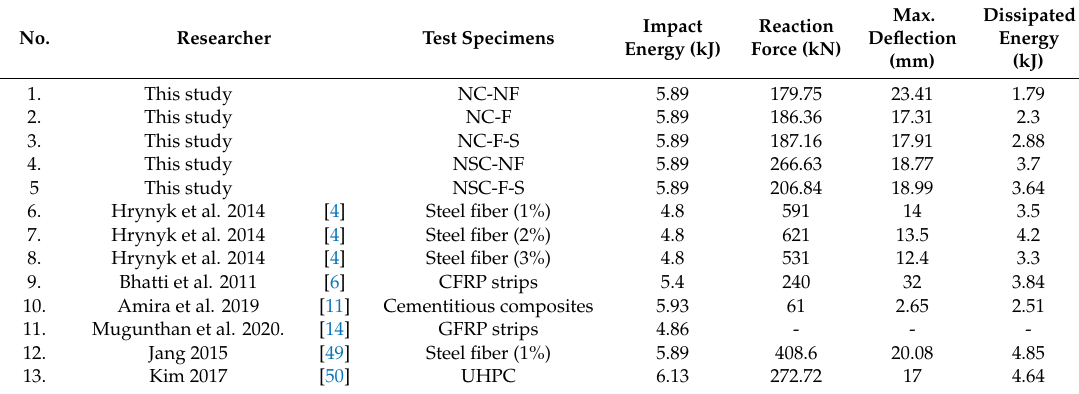
Table 10. Recent research about two-way RC slab under impact